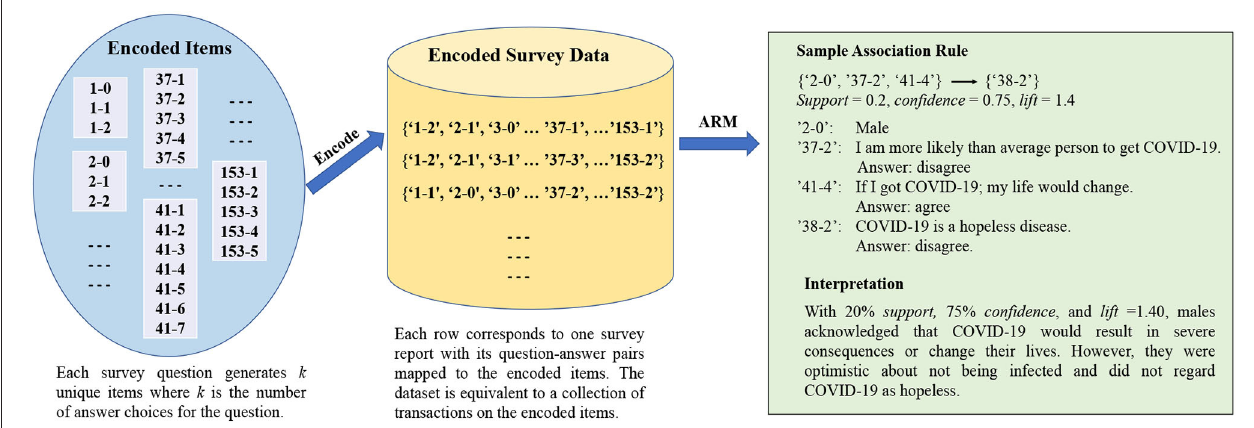
FIGURE 1 | Association rules generation from survey